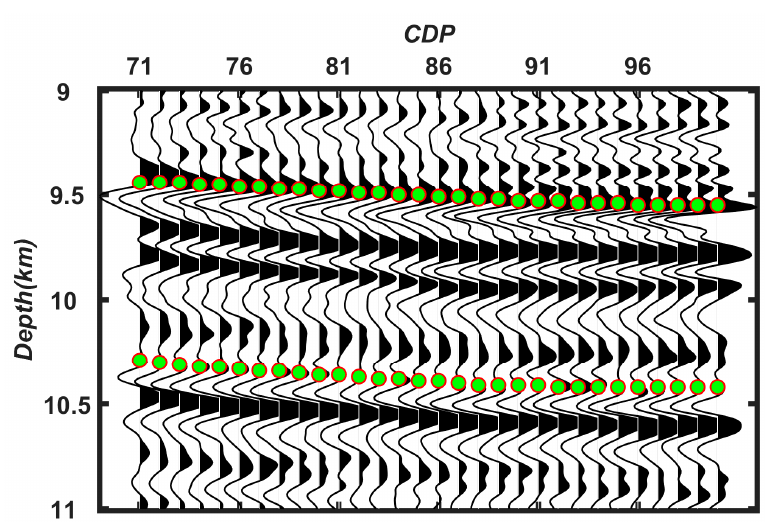
Figure 8. The extracted horizons for land data.